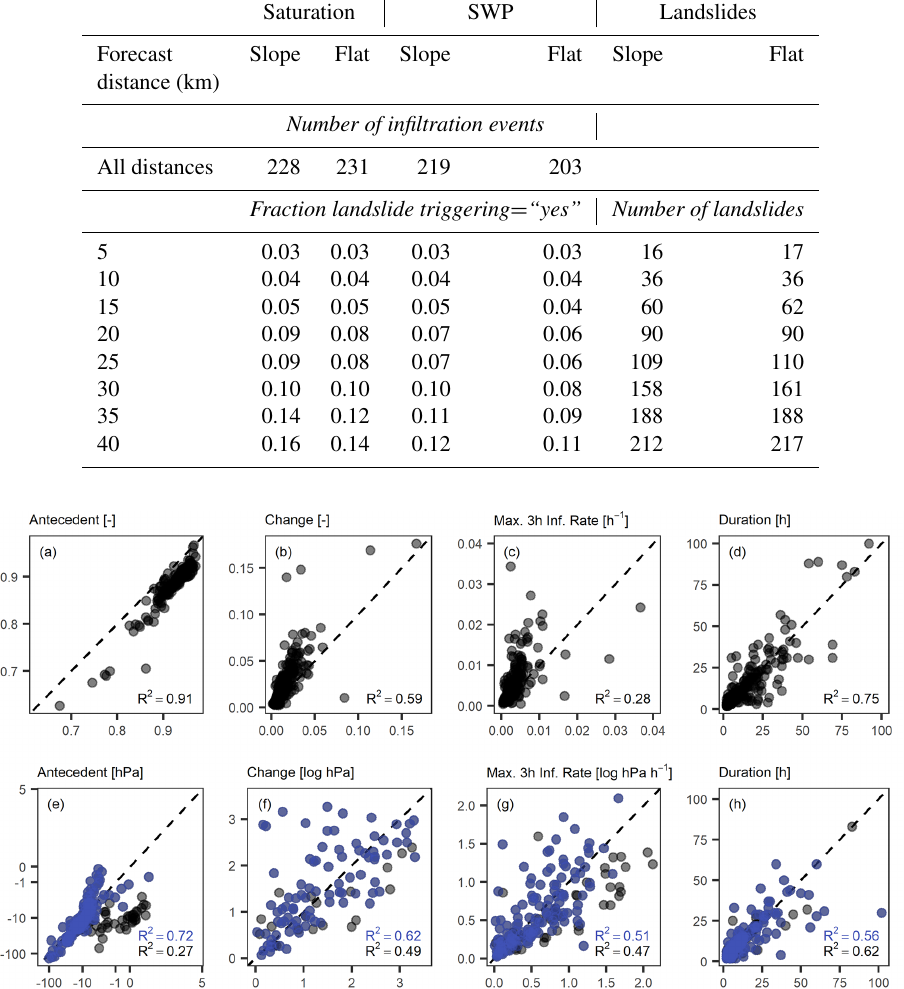
Table 3. Number of infiltration events identified per site, and the fraction of landslide-triggering events as function of forecast distance for both saturation and SWP time series, as well as number of landslides observed during the study period per site within a specific forecast distance.